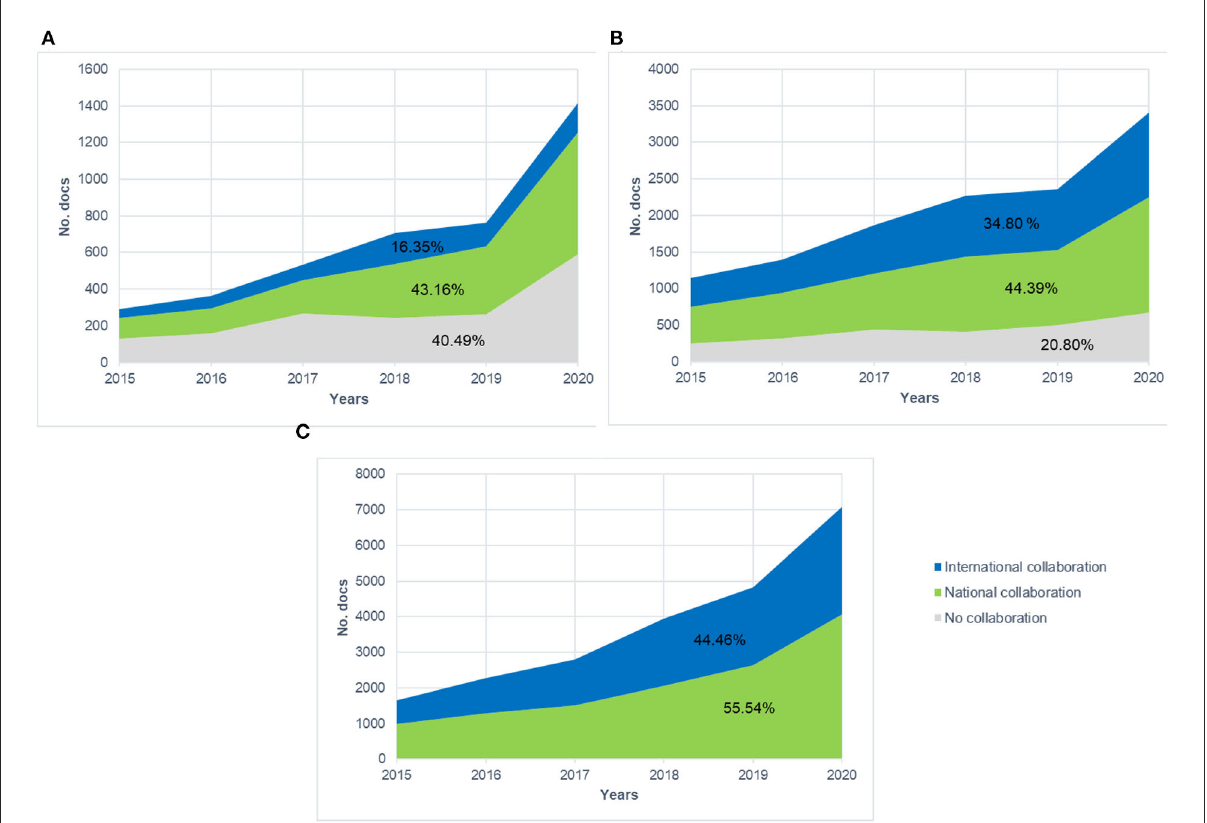
FIGURE2 Collaboration evolution (2015–2020) of (A) papers authored by women; (B) papers authored by men; (C) mixed-gender papers, in international collaboration (blue), national collaboration (green), and no collaboration (gray).